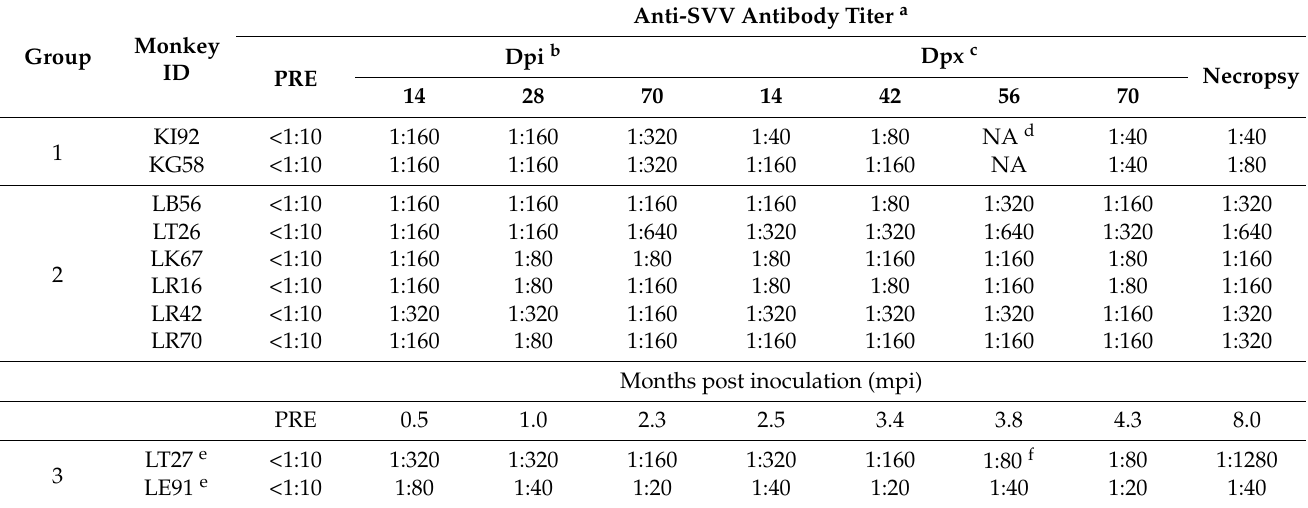
Table 5. Neutralizing antibody titers during varicella and